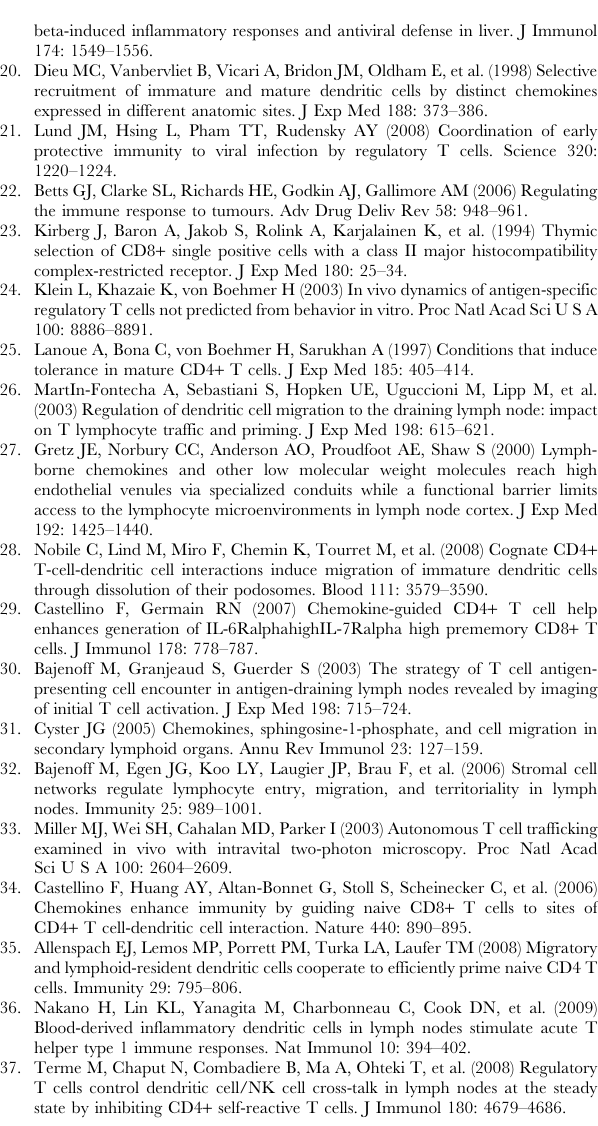
Figure S3 Poor co-localization of unloaded DCs and HA- specific T cells. Mice were adoptively transferred with CFSE- labelled 6.5 cells from stg mice and one day later were injected with CMTMR-positive DCs that were loaded with the